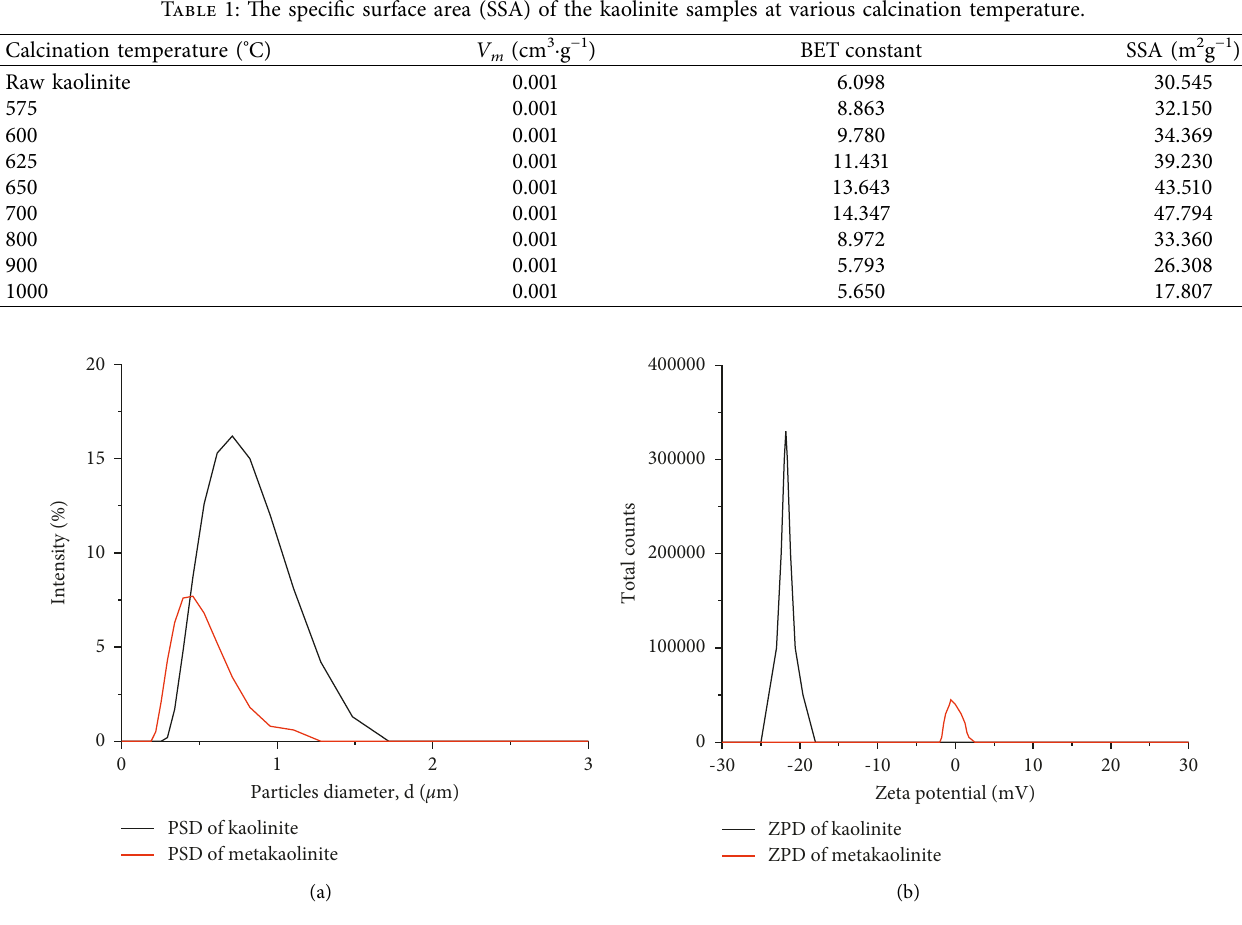
Figure 2: (a) PSD and (b) ZPD of kaolinite and metakaolinite.